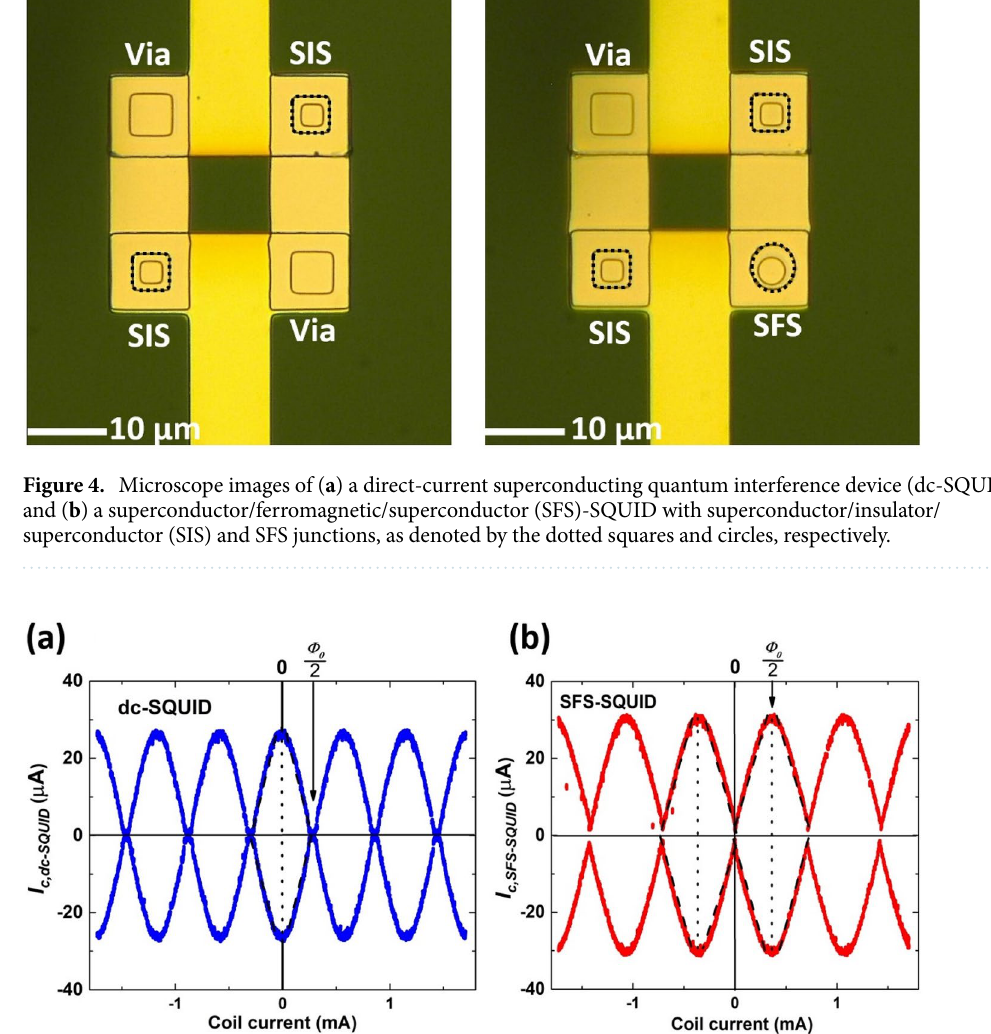
Figure 5. Magnetic field-dependent critical currents of ( a ) the dc-SQUID and ( b ) SFS-SQUID. The arrows indicate the field value at a